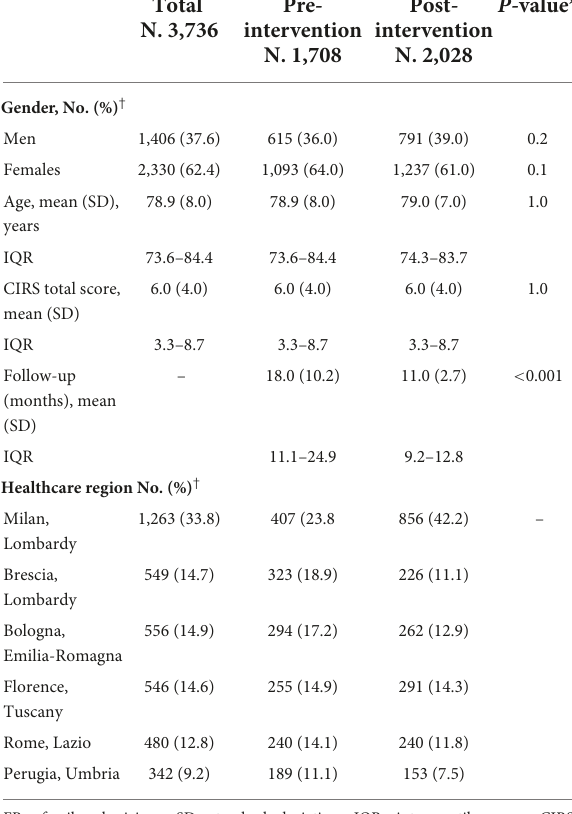
TABLE 1 Baseline characteristics and follow-up of patients identified by FPs as having cognitive decline in six health authorities of five Italian regions, total and stratified by pre- and post- educational